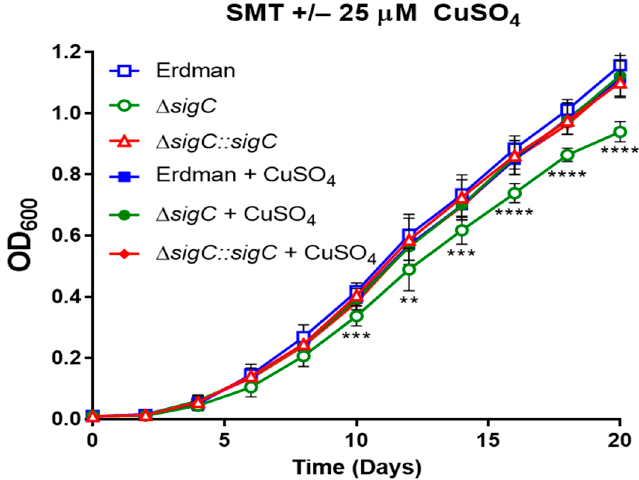
Figure 6. Restoration of wildtype growth of Δ sigC in SMT with 25 µM copper. Growth was monitored for strains Erdman, Δ sigC , and Δ sigC::sigC cultured in SMT medium without or with 25 µM copper sulfate supplementation. Results shown are the averages of 2 experiments with 3 replicates per strain. One-way ANOVA was used to assess statistical significance between groups (** p < 0.01, *** p < 0.001, **** p < 0.0001).